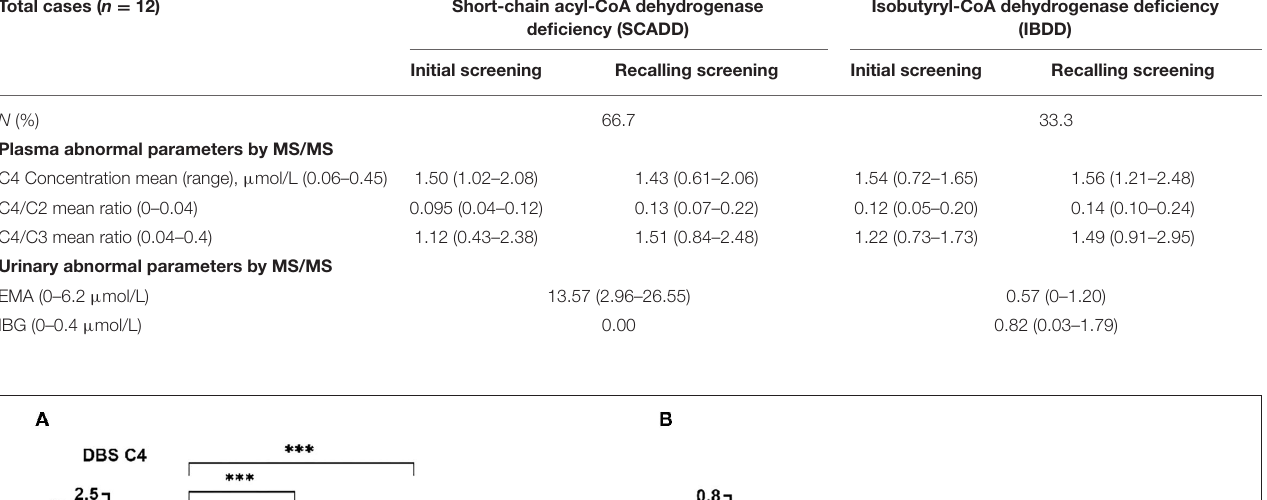
TABLE 1 | Levels of abnormal parameters for the two associated different disorders with C4 by MS/MS and urinary GC/MS.